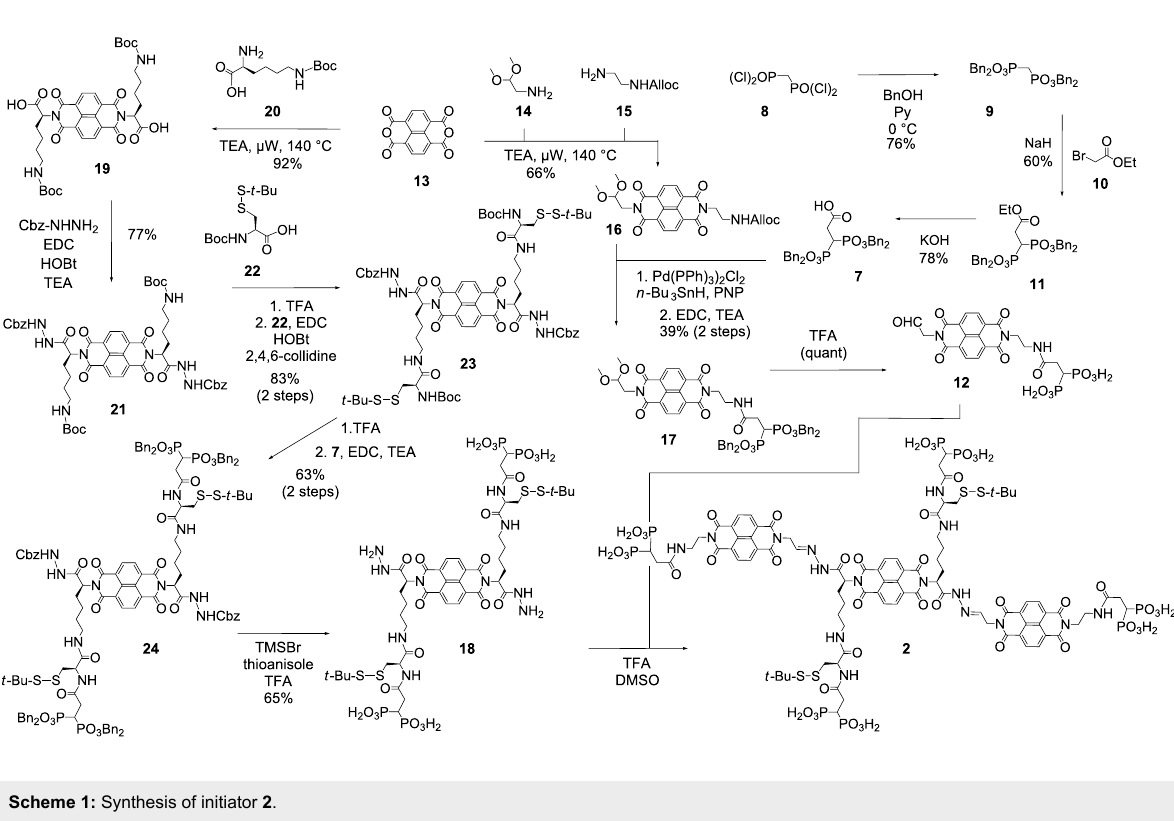
Scheme 1: Synthesis of initiator 2 .